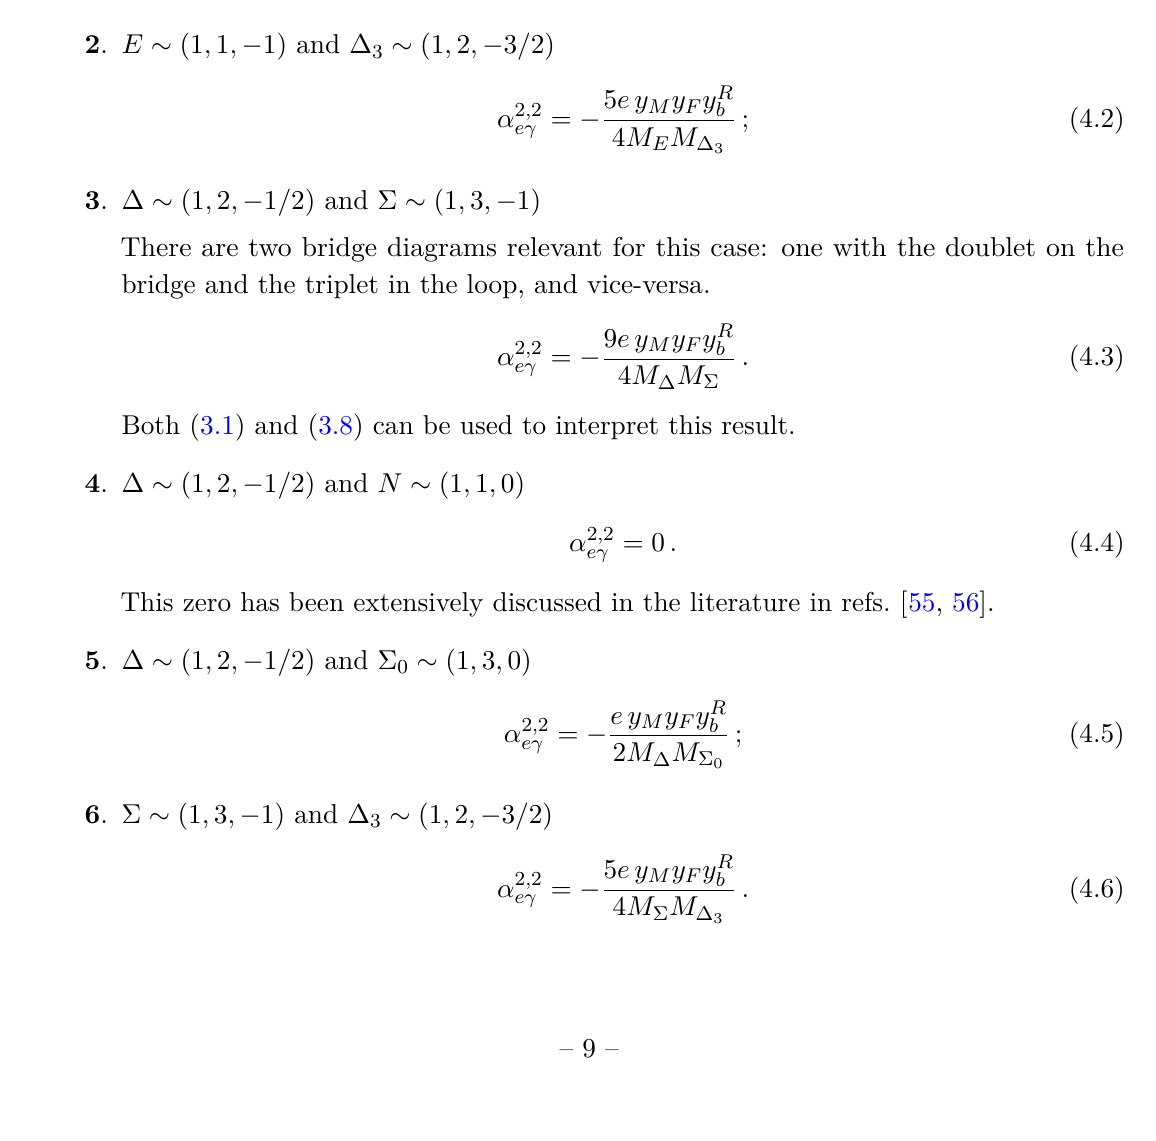
Table 1 . 2-field UV completions which generate the bridge topology, with only two heavy propagators. However we consider all possible topologies for the presented a µ result both those coming from single field topologies and from the box